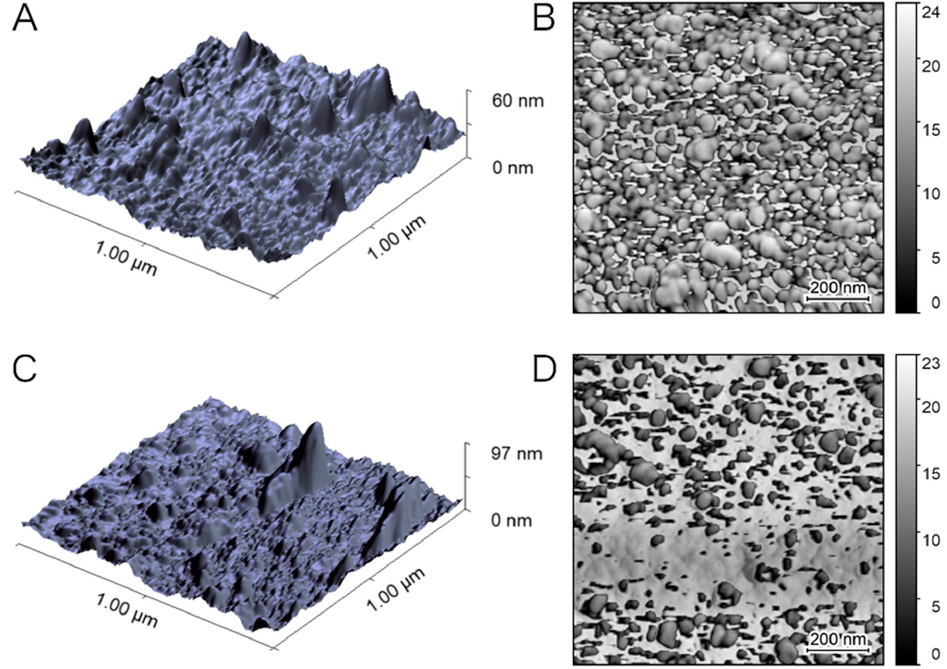
Figure 2. The nanogel–POF interface in wet and dry conditions. Atomic force microscopy was used to investigate: ( A ) surface topography of nanogel–POF probe in a hydrated state, and correlated